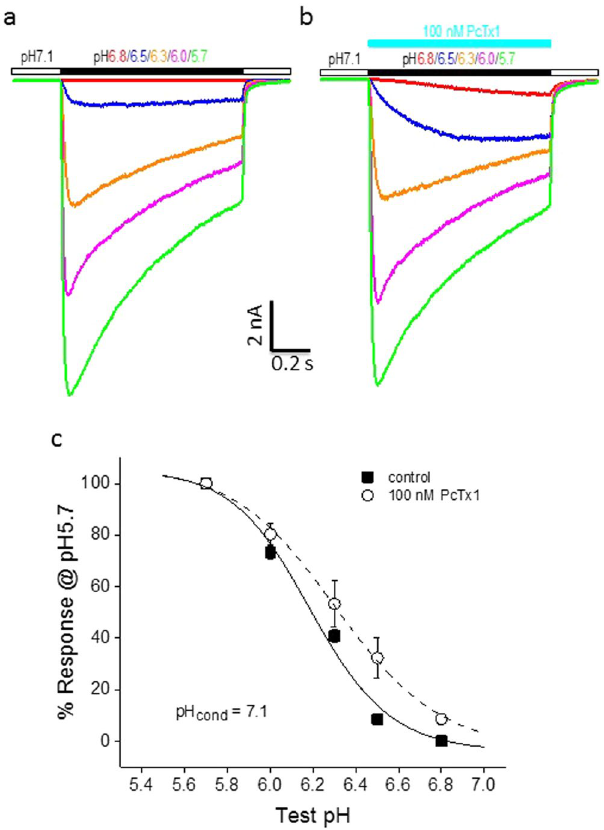
Figure 3. PcTx1 shifted pH activation of ASIC1a/2a toward lower proton concentrations in CHO cells. ( a ) Current traces from a single cell showing activation of ASIC1a/2a at various test pHs (pH6.8–5.7) in the absence of PcTx1. ( b ) Current traces from the same cell as in ( a ) showing activation of ASIC1a/2a at the same test pHs in the presence of 100 nM PcTx1. ( c ) Average current responses as a function of test pH in the absence (solid squares) and presence (open circles) of 100 nM PcTx1. Current amplitudes were normalized to that at pH5.7 for each cell in the absence (n = 6) and presence (n = 4) of PcTx1, respectively. The solid and dashed lines are best fits to the data in the absence (pH 50 = 6.19) and presence (pH 50 = 6.31) of 100 nM PcTx1, respectively. PcTx1 significantly (P < 0.05) shifted the pH activation curve to lower H + concentrations. The conditioning pH was 7.1 for all the experiments in Fig.